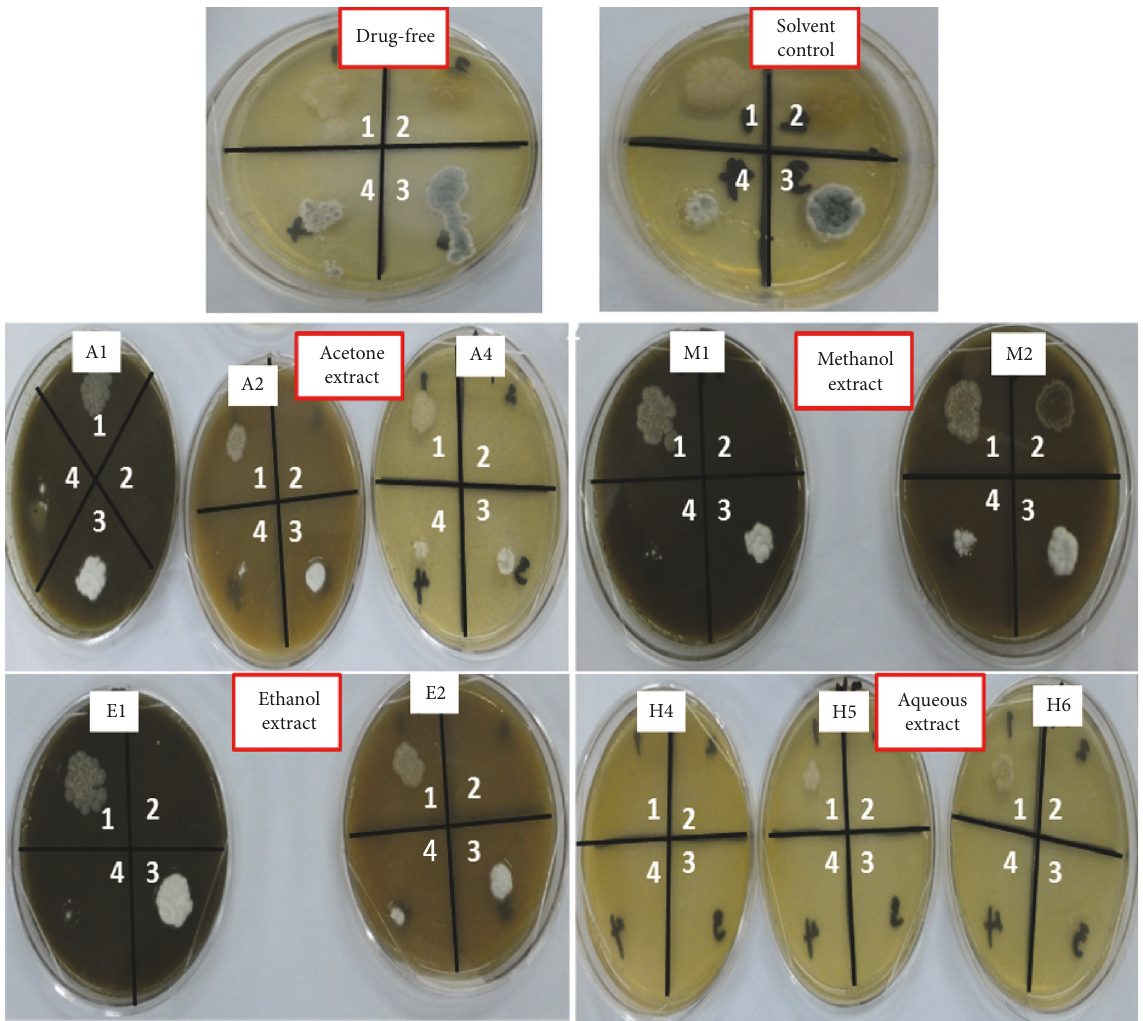
Figure 2: Representation of the antifungal MIC determination of P. capitata against the tested fungi using the agar dilution technique . Annotations: Values 1–4 are the fungi used which are as follows: 1 = Trichophyton mucoides ; 2 = Trichophyton tonsurans; 3 = Candida albicans; and 4 = Aspergillus niger. A1, A2, and A4, M1 and M2, E1 and E2, and H4, H5, and H6 are the different concentrations used with the highest concentration being 1 (10mg/mL) and the least concentration being 6 (0.3125 mg/mL). Spots on plates are fungi growth indicating resistance of the organism(s) at that